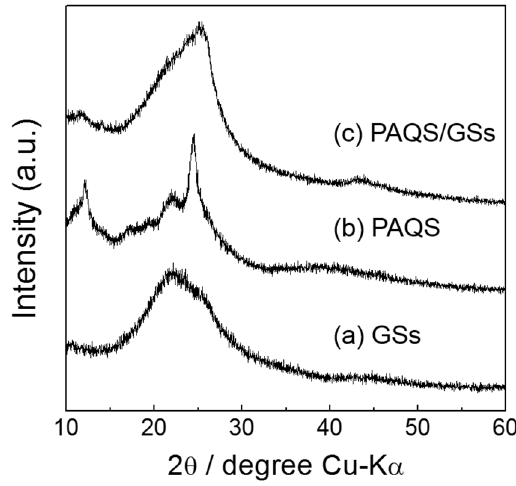
Figure 3. XRD patterns of ( a ) GSs; ( b ) PAQS and ( c )